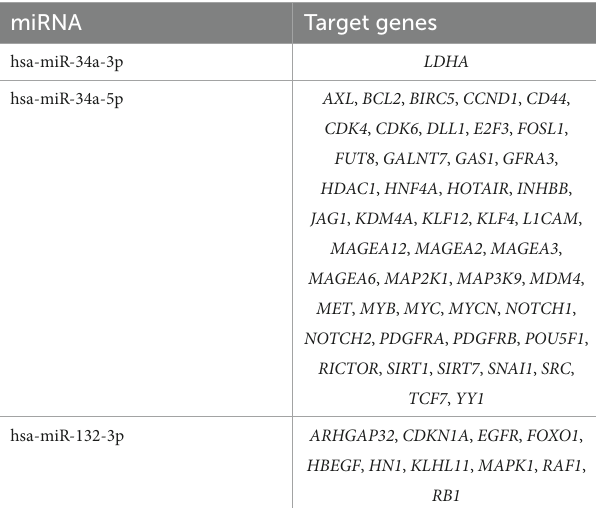
TABLE 2 Experimentally confirmed hsa-miR-34a and hsa-miR-132 target genes, associated with five investigated neurodegenerative disorders and